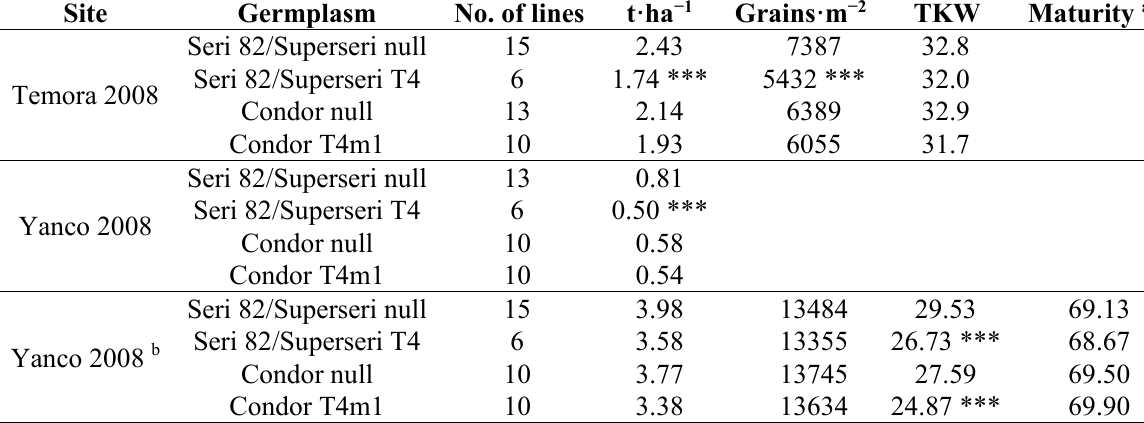
Figure 2. The percentage change attributed to the T4 translocations for ( a ) seeds·m −2 and ( b ) TKW. T4m2 only had two data-points. Table 3. Effects of the T4 and T4m1 translocations on yield (t·ha −1 ), grains·m −2 , thousand kernel weight (TKW) and maturity. Comparisons were made from two sets of sister lines that segregated for the original T4 translocation in the Seri 82/Superseri cross, and for the T4m1 translocation in a highly backcrossed Condor